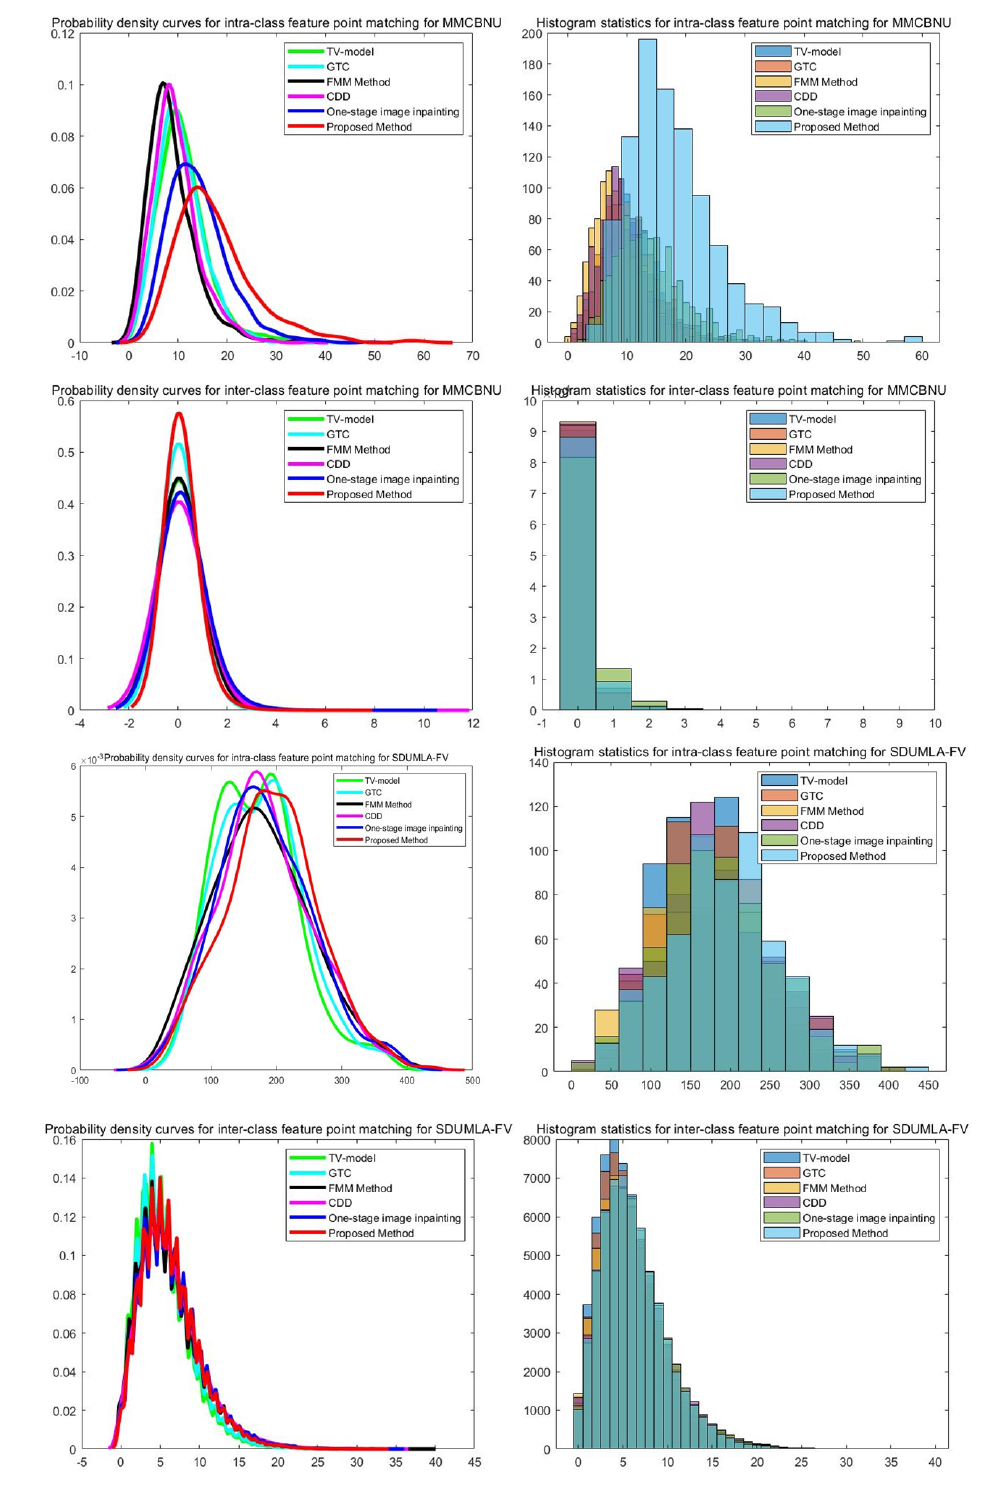
Figure 12. The intra-class and inter-class probability density distribution plots and feature point histogram statistical plots of various image restored methods on the MMCBNU and SDUMLA-FV